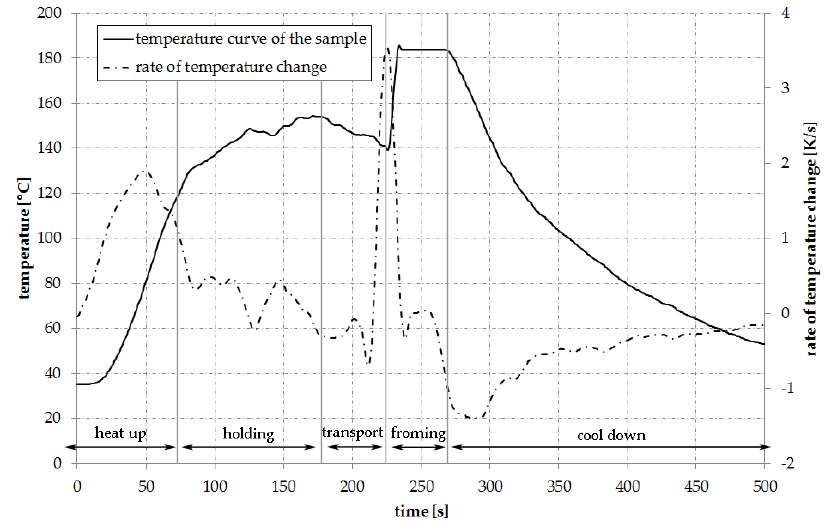
Figure 4. Temperature measurement of a sample during the process.